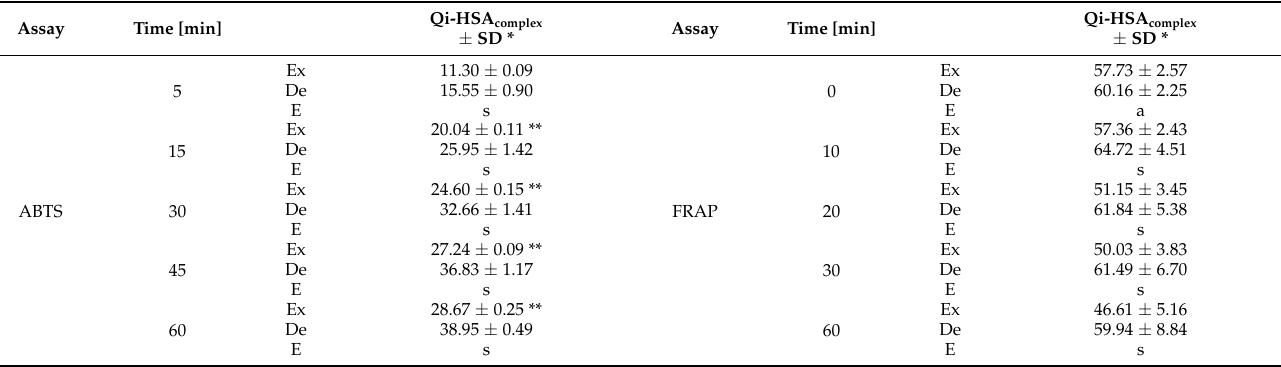
Table 8. Expected versus designated values of